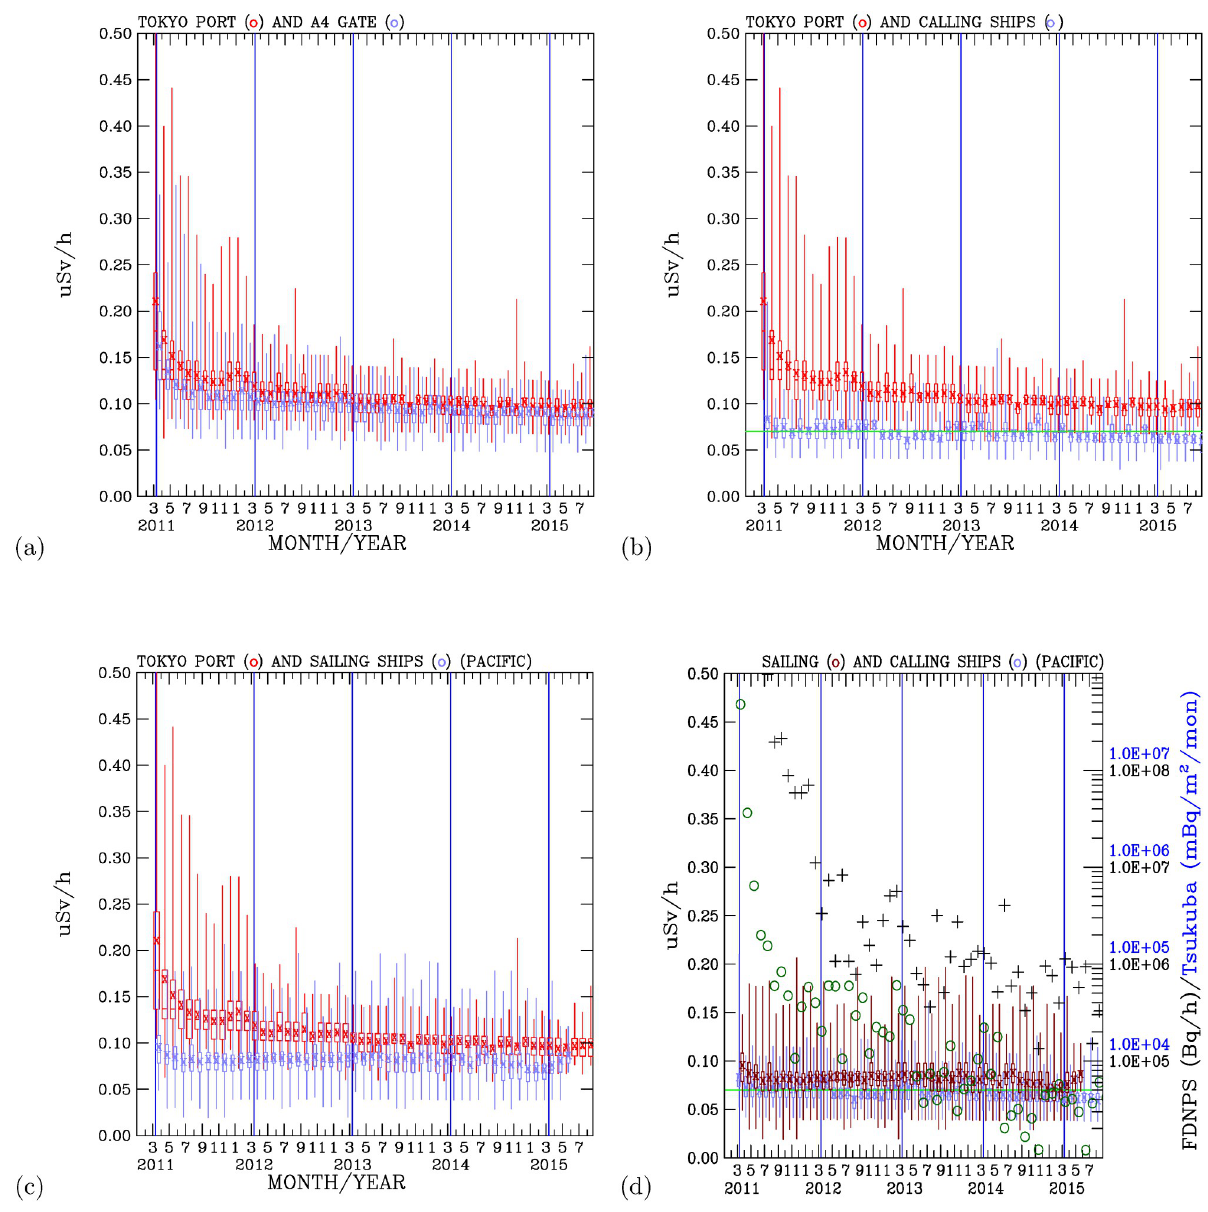
Fig 6. Comparisons of dose rate measurements. Measurements made at the Port of Tokyo office attic (red colored lines) compared with those made at (a) gate A4 (blue colored lines), (b) the Port of Tokyo calling ships (blue colored lines), and (c) the Pacific sailing ships (blue color lines). (d) Measurements made on the calling ships (blue colored lines) at the Port of Tokyo compared with those made on the Pacific sailing ships (dark brown lines, FDNPS emission fluxes (black crosses) and the Tsukuba deposition fluxes (blue open circles).